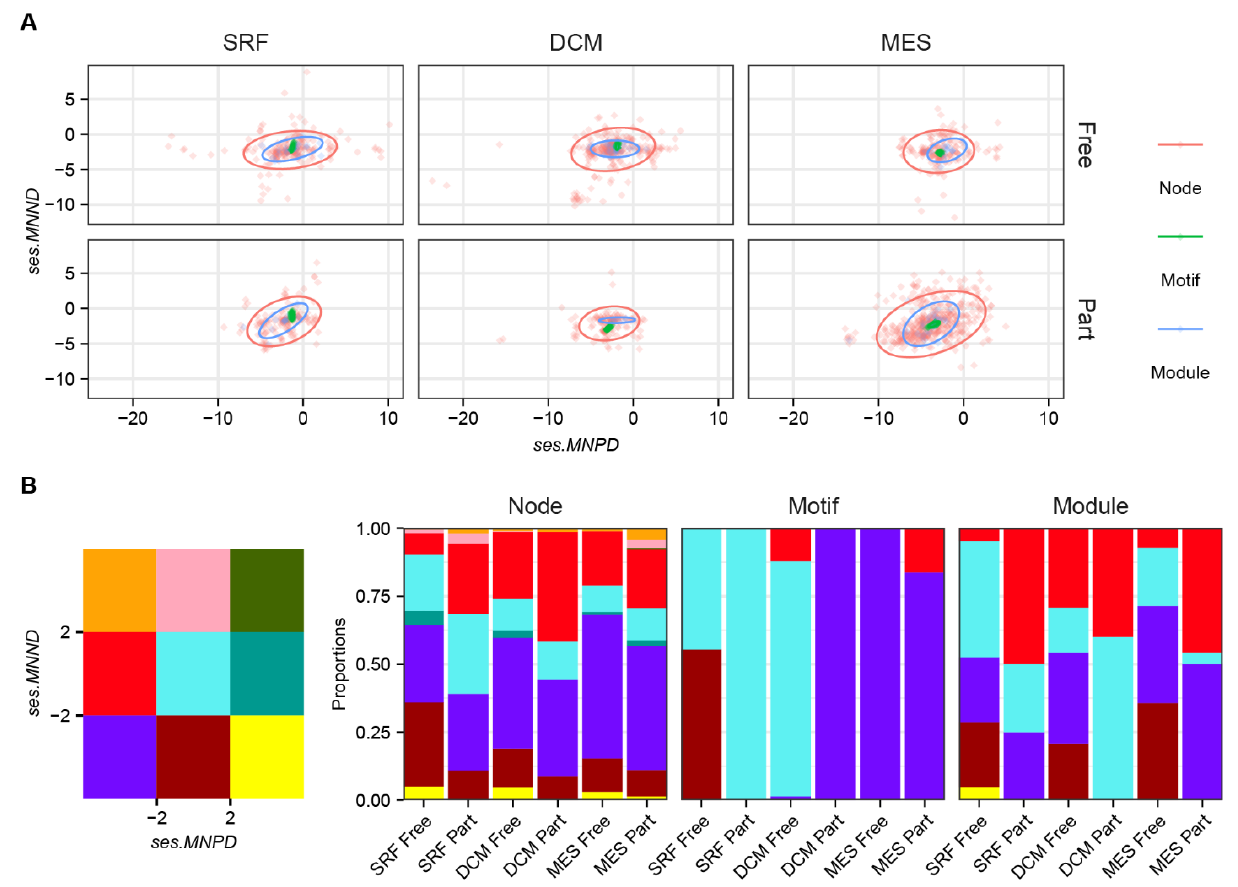
Figure 4. The mean neighbor phylogeny and niche distance of species in microbial networks. ( A ) The ses.MNPD – ses.MNND plot for marine microbial communities across node, motif and module levels, where ses.MNPD or ses.MNND of motifs and modules were calculated according to the proportions of their node members. ( B ) The block proportions in ses.MNPD – ses.MNND plots across nodes, motifs and modules, where a ses.MNPD (or ses.MNND ) larger than 2 indicates that one object has a significant preference in a more distantly related phylogeny (or niche) at same network level, while a ses.MNPD (or ses.MNND ) less than − 2 indicates one object has significant preference in a more closely related phylogeny (or niche).